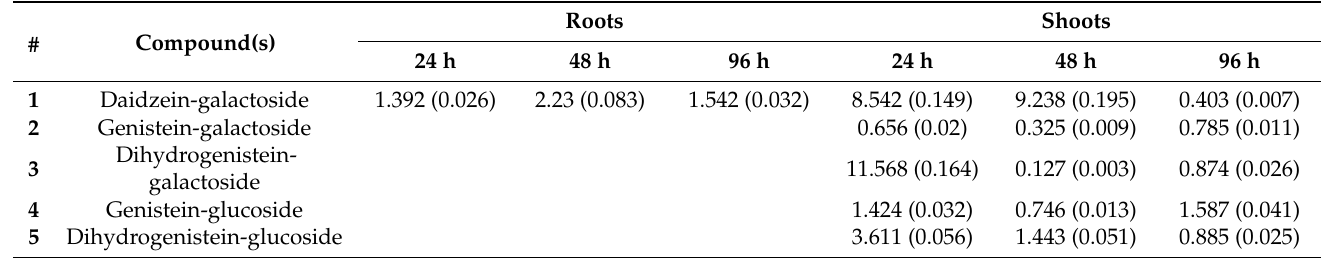
Table 9. Fold change values of NNMF vs. GMF polyphenols in Arabidopsis thaliana time-course experiments from Supplementary Table S4. Fold change values are expressed along with standard deviation and calculated from the quantitative data of Supplementary Table